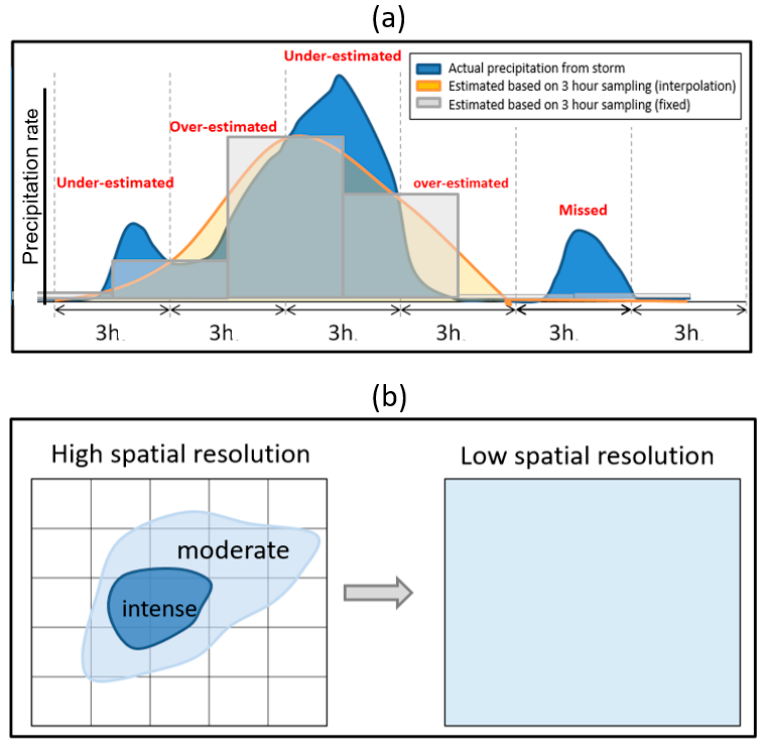
Figure 1. A schematic representation of temporal and spatial errors resulted from poor temporal ( a ) and spatial ( b ) sampling. The low resolution grid in Figure 1b (right side) is shown in light blue that represents average of intense (shown in dark blue), moderate, and zero (in white) rain rate shown in the left panel.